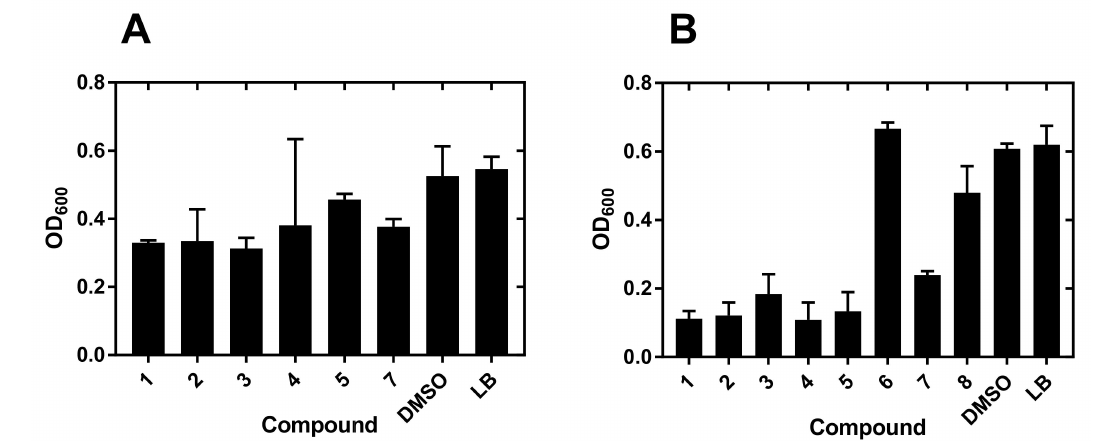
Figure 2. Growth inhibition of Y. enterocolitica by metallacarboranes. ( A ) Bacterial growth inhibitors selected from a 20 µ M screen against Y. enterocolitica . Only compounds showing at least 50% growth inhibition are shown. ( B ) Bacteria were grown in 96-well flat-bottom plates at 37 ◦ C in the presence of 200 µ M compounds for 24 h. The growth was followed by measurement of OD600 absorbance as described under Materials and Methods. Measurements at 8 h post-inoculation are shown. Error bars correspond to the SEM value from 3–5 measurements. DMSO, dimethyl sulfoxide; LB, Luria-Bertani broth.